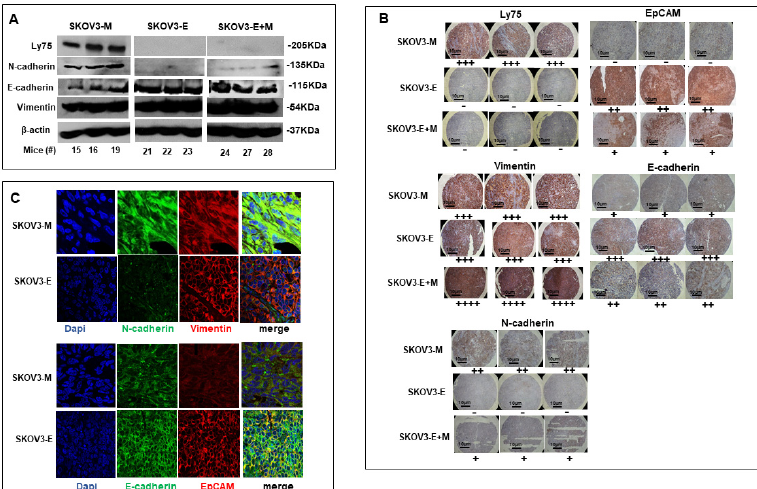
Figure 4. Protein expression analysis of different EMT markers in tumor tissues extracted from mice IB-injected with SKOV3-M, SKOV3-E and SKOV3-E+M cells. ( A ) Western blot analysis of the protein expression of LY75, vimentin, N-cadherin and E-cadherin, and EpCAM in tumor tissues extracted from mice IB-injected with SKOV3-M, SKOV3-E and SKOV3-E + M cells. β -actin was used as a loading control. ( B ) Representative immunohistochemistry (IHC) images of the protein expression of LY75, vimentin, E-cadherin, N-cadherin and EpCAM in tumor tissues extracted from mice injected with the SKOV3-M, SKOV3-E and SKOV3-E + M cells. Magnification at 40 × (scale bar 10 µ m). The plus symbols ( + to ++++ ) indicate the level of expression (from lower to higher) of the corresponding protein. The minus ( − ) symbol means no expression. ( C ) Immunofluorescence analysis of the protein expression of N-cadherin, vimentin, E-cadherin and EpCAM in tumor tissues extracted from mice IB-injected with SKOV3-M and SKOV3-E cells (magnification at 60 ×